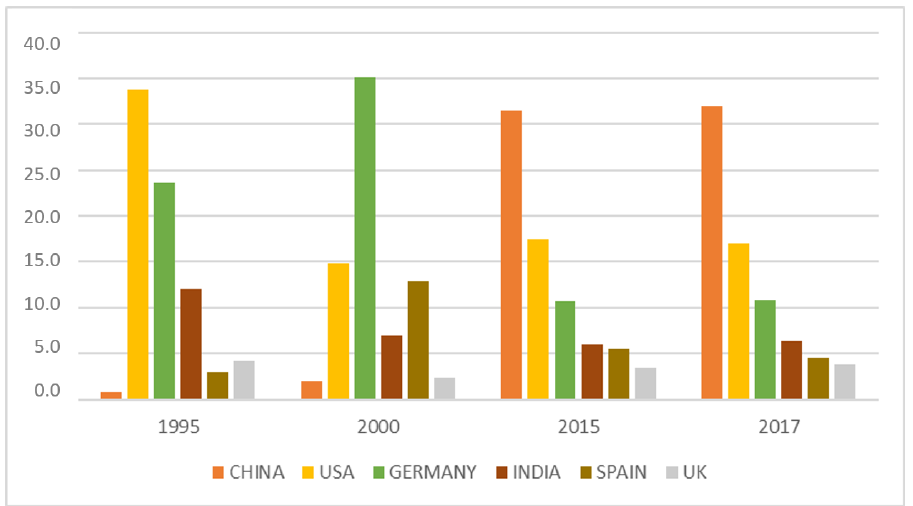
Figure 1. Top six countries by cumulative wind energy capacity (%) (MW) (1995 – 2017) elaborated from [66].